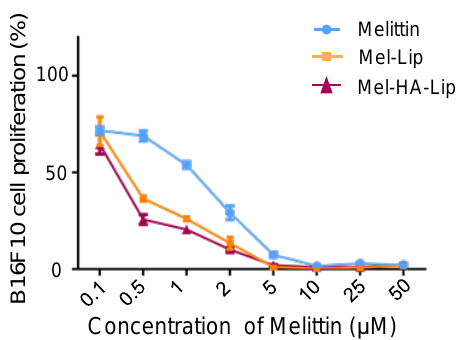
Figure 9. Cytotoxicity of B16F10 cells following treatment with free melittin (Melittin), Mel-Lip, and Mel-HA-Lip. ( n = 3).